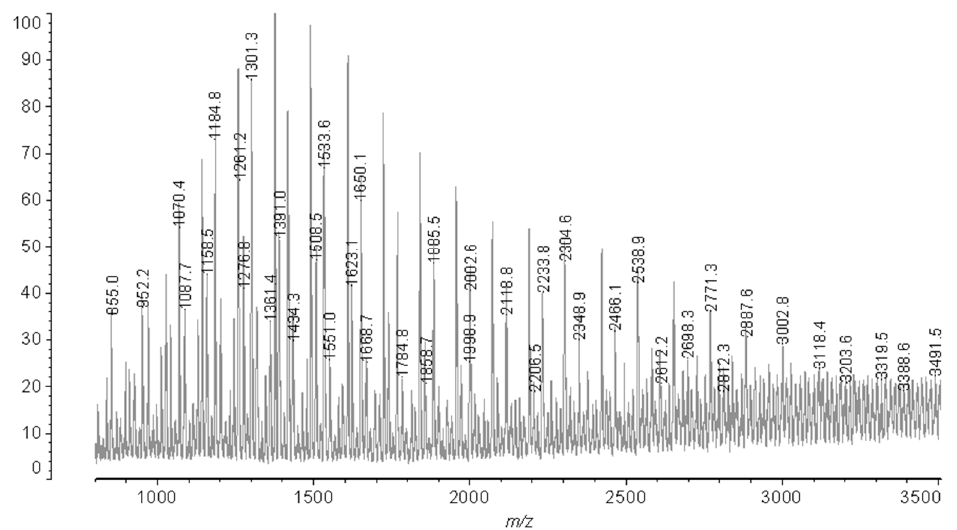
Figure 12. MALDI-TOF spectrum of PIPGE/PBO/PIPGE-diol (18).